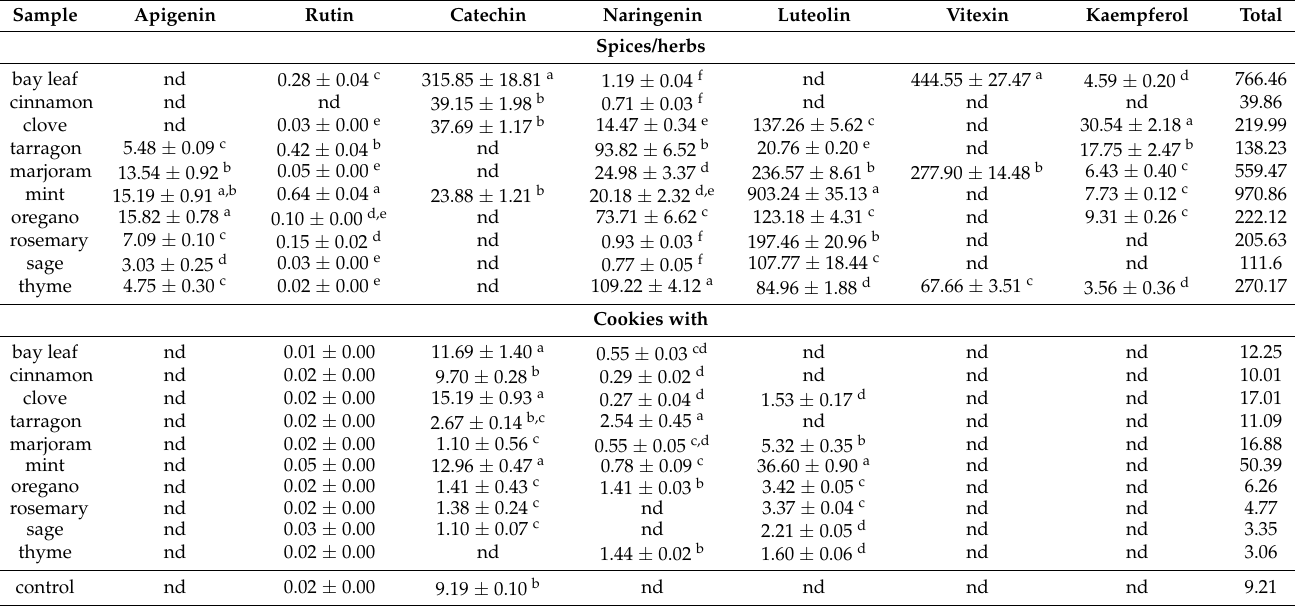
Table 2. Content of flavonoid compounds in 80% methanolic extracts of the analysed spices/herbs and extracts of cookies with their contribution. Data presented as µ g/g of DM; nd—non